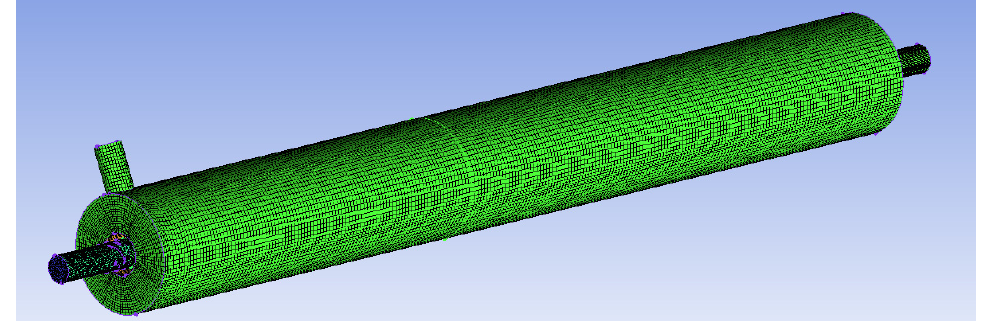
Figure 3. Axial flow gas-liquid separator mesh.